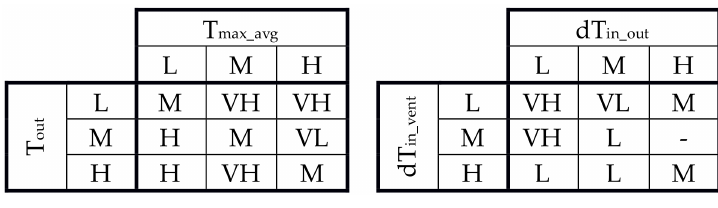
Figure 13. Rule base for O1-TCC.